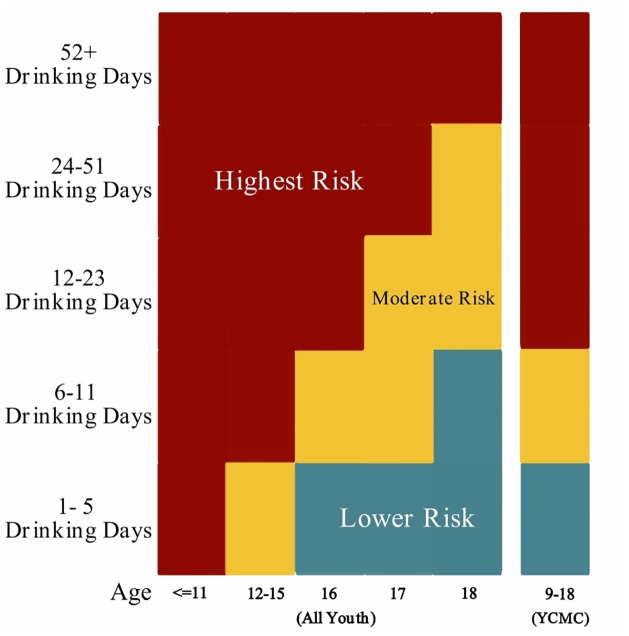
Comparison of estimated risk levels by age and response using NIAAA Youth Alcohol Screening Tool for all youth and YCMC.Screening question assessed the number of drinking days in the past year [19].